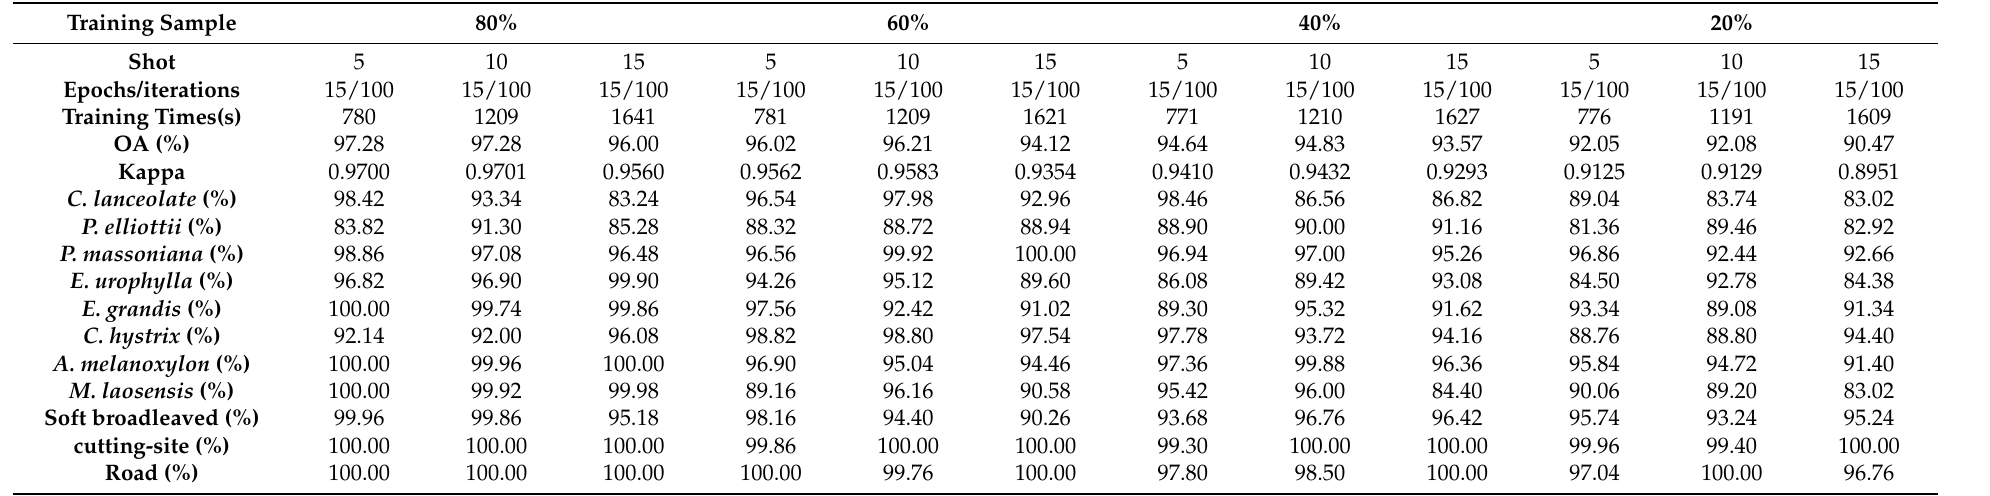
Table 8. Classification accuracy of different training set